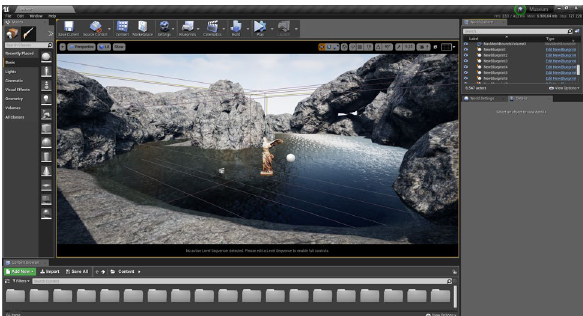
Figure 8. View of the virtual model within Unreal Engine